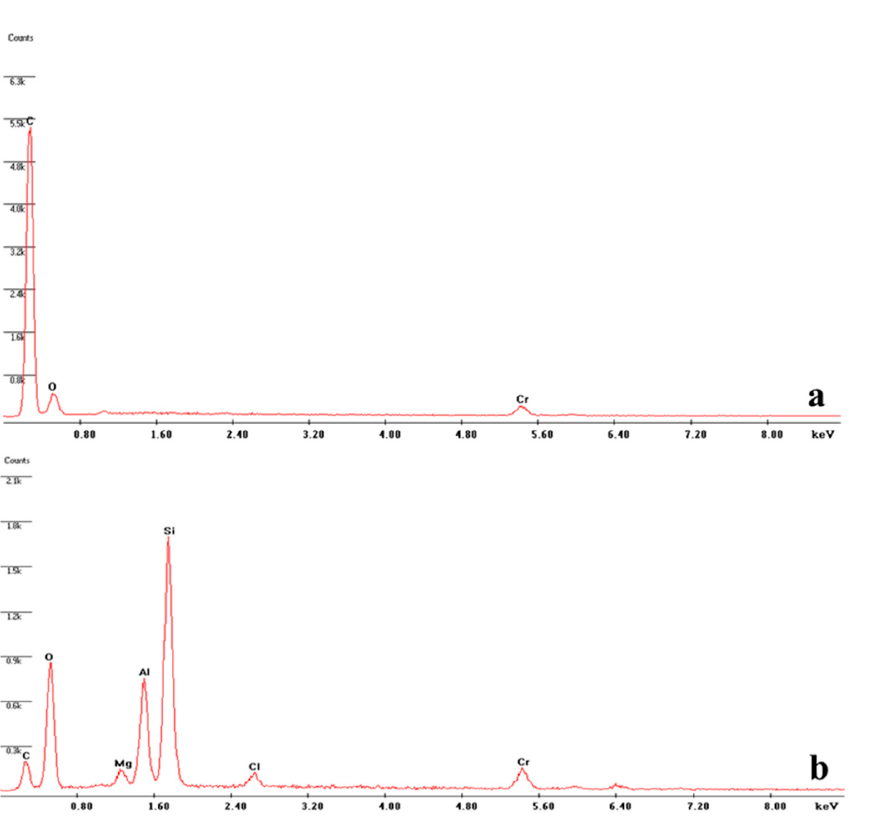
Figure 2. SEM images of the GCE/COOH-PPy/NH 2 -NCY at different magnifications.